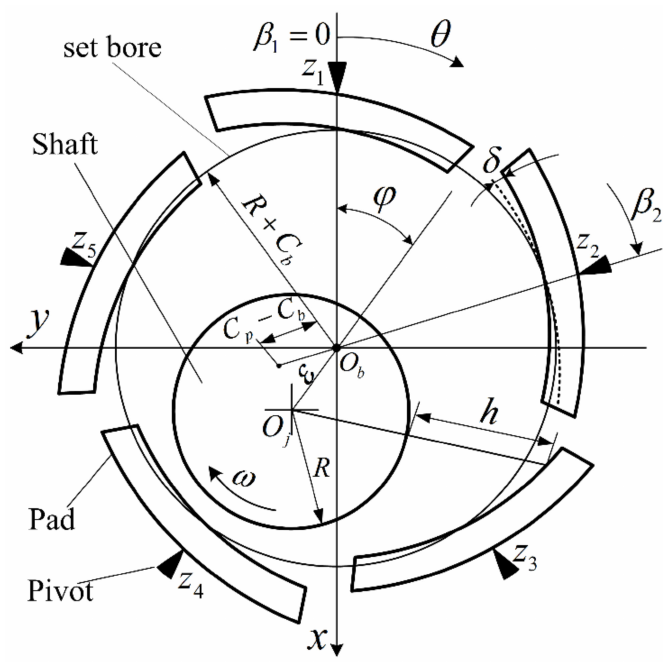
Figure 1. Schematic of tilting pad bearing (load between